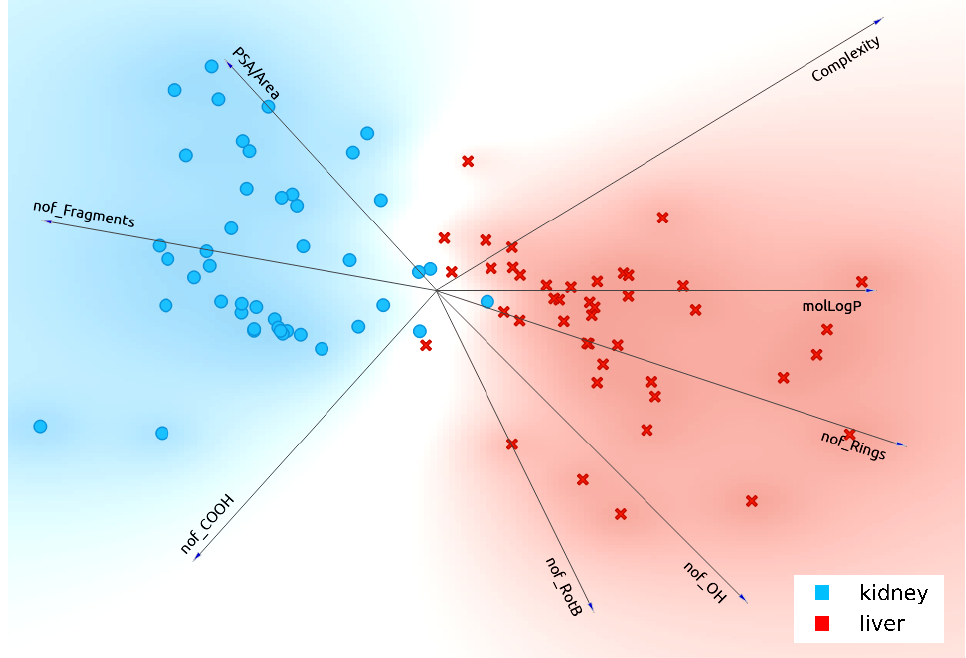
Figure 2. FreeViz diagram segregating kidney and liver drugs based on selected molecular features. FreeViz diagram is one method to analyze the likely importance of the chosen features for determining the interaction of drugs with liver OATPs (Complexity, molLogP, nof_Rings, nof_OH, nof_RotB) versus kidney OATs (nof_COOH, nof_Fragments, PSA/Area). In the figure, length of the arrow reflects the magnitude of the feature according to FreeViz optimization method, and angle between the arrows reflects the correlation between features.